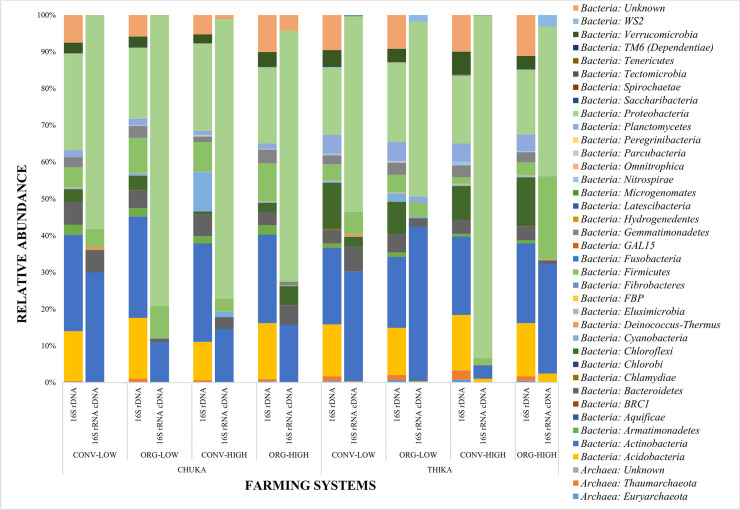
Relative abundance of the most predominant phyla in both datasets at Chuka and Thika sites.